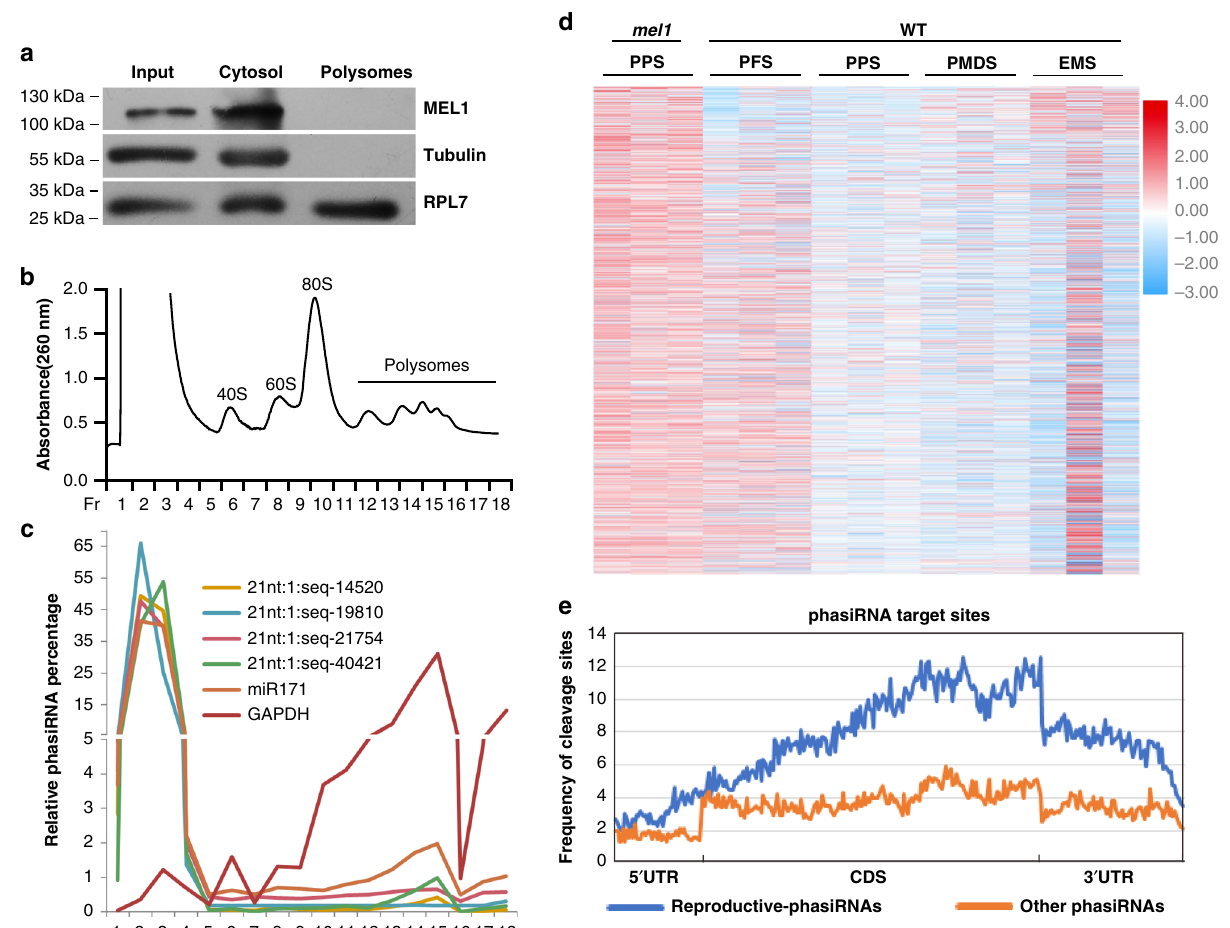
Fig. 1 Analysis of MEL1-dependent phasiRNAs and their target preference and rules. a Western blot analyses the distribution of MEL1 protein. 60s ribosomal protein L7 (RPL7) and tubulin were used as controls. Uncropped blots in Source Data. n = 3 independent replicates. b Sucrose-gradient analysis of extracts from wild-type (WT) PMC premeiosis-stage spikelets. Fractions 1 – 5 are the supernatant; fractions 6 – 11 are the 40s – 80s; fractions 12 – 18 are polysomes. c The distribution of phasiRNAs and two controls (miR171 and GAPDH ) in each sucrose-gradient fraction were quanti fi ed by qRT-PCR. Relative distribution of the RNA in each fraction was normalized by the total abundance of RNA in all fractions marked as 100%. n = 3 independent replicates. d Heatmap of all target coding genes of reproductive phasiRNAs in WT and mel1 during anther development. Gene expression values used to create the heatmap are the log 2 FPKM (Fragments Per Kilobase Million) of the target genes of reproductive phasiRNAs, and the values were scaled by